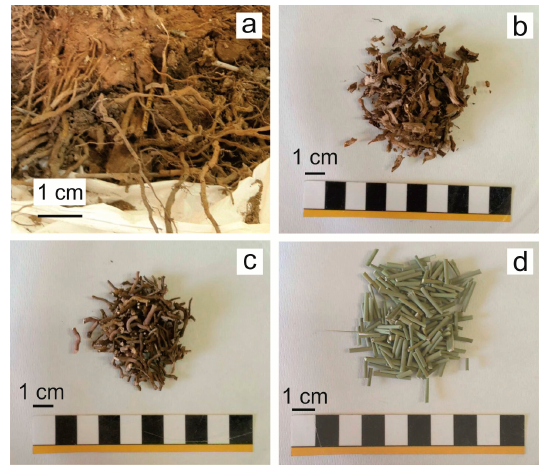
Figure 2. Images of rhizosphere ( a ), external surface of roots (epidermis) ( b ), internal roots ( c ), and stems ( d ) of Juncus acutus collected along the Rio Irvi (SW Sardinia).